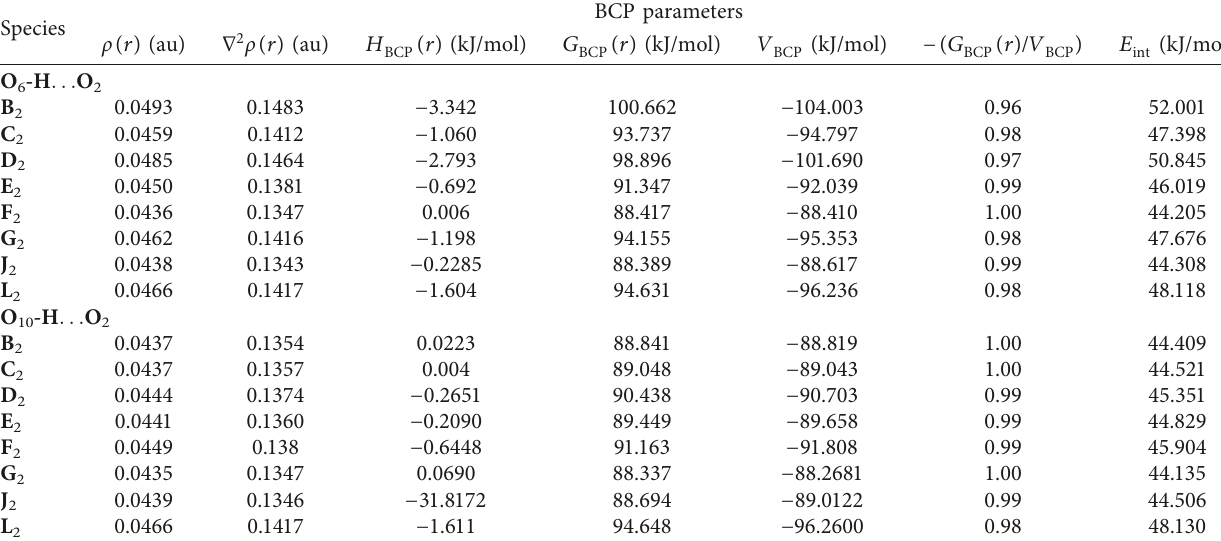
Table 2: Bond critical point parameters of intermolecular hydrogen bonds: electron density, Laplacian of the electron density, and hydrogen bond strength (kJ/mol) (calculated from B3LYP/6-311++G(d,p) wave function in gas phase) for anthraquinone and its derivatives.